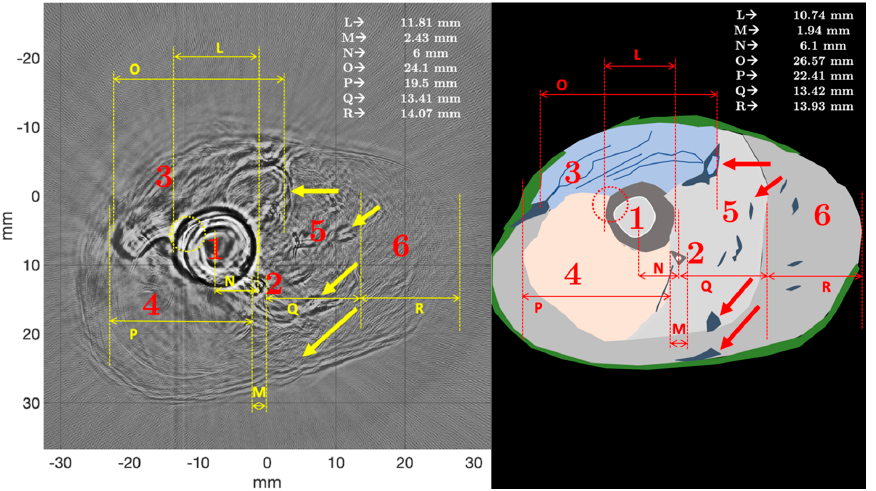
Figure 14. Morphometric analysis of the ex vivo chicken drumstick by comparing USCT and μ CT. The solid arrows indicate specific morphological zones.